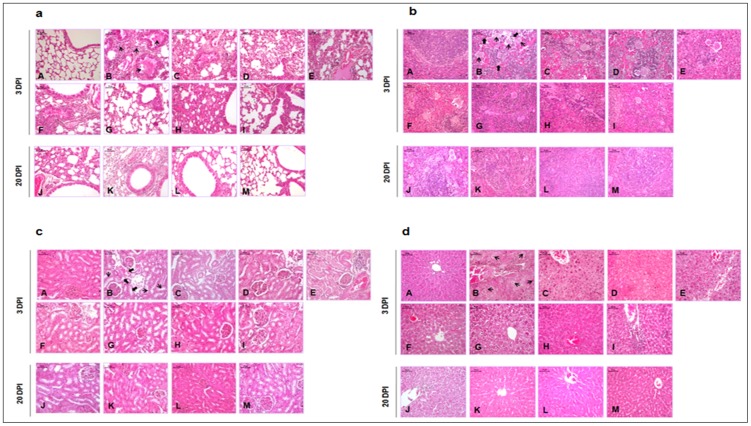
Histopathology of the organs collected from the immunized group animals on 3rd and 20th day post infection with Y. pestis and the naive control animals that were neither immunized nor challenged with Y. pestis.Tissue sections were stained with hematoxylin and eosin for pathological examination. Tissue section collected from naive control and immunized animals on 3rd day post infection i.e., Naive control (A); PBS control (B); HSP70(II) (C); F1 (D); F1+HSP70(II) (E); LcrV (F); LcrV+HSP70(II) (G); F1+LcrV (H); F1+LcrV+HSP70(II) (I). Tissue sections were collected from the survived animal groups on 20th day post infection i.e., LcrV (J); LcrV+HSP70(II) (K); F1+LcrV (L); F1+LcrV+HSP70(II) (M). Photomicrograph represents the histopathology of Lung[a]: the arrows in the panel B indicate the infiltration of neutrophils. Photomicrograph of spleen [b]: in the panel B, reduced density of white pulp follicle and congestion in the red pulp, lymphoid follicle depletion shown by arrow and the presence of megakaryocytes shown by bold arrow. Photomicrograph of kidney [c]: the granular degeneration of parenchyma was observed in the panel B (bold arrows) and swelling in renal tubules (arrows). Photomicrograph of liver [d]: in the panel B, the hepatocytes degeneration was observed as indicated by arrow.